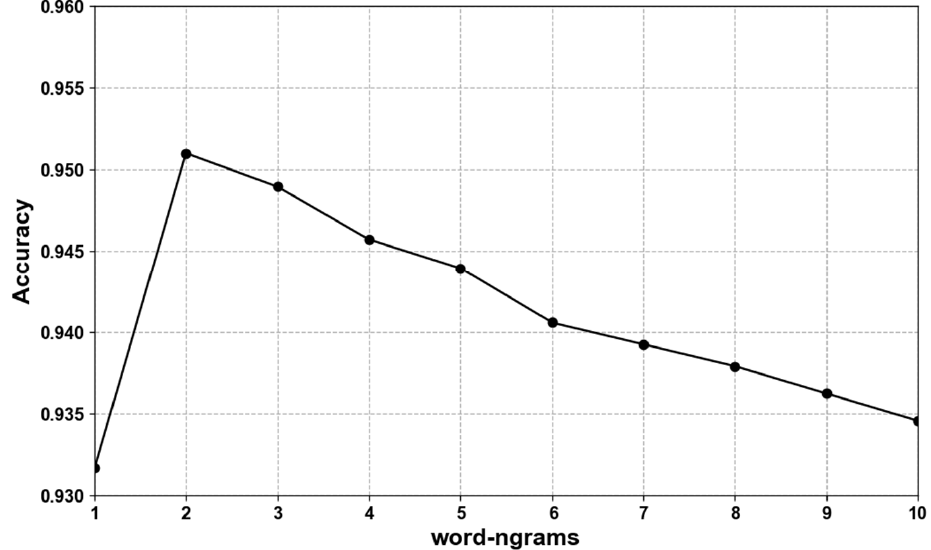
Figure 8. Accuracy at different -ngrams of FastText model (dimensions = 2; learning rate = 0.01; neg = 10).